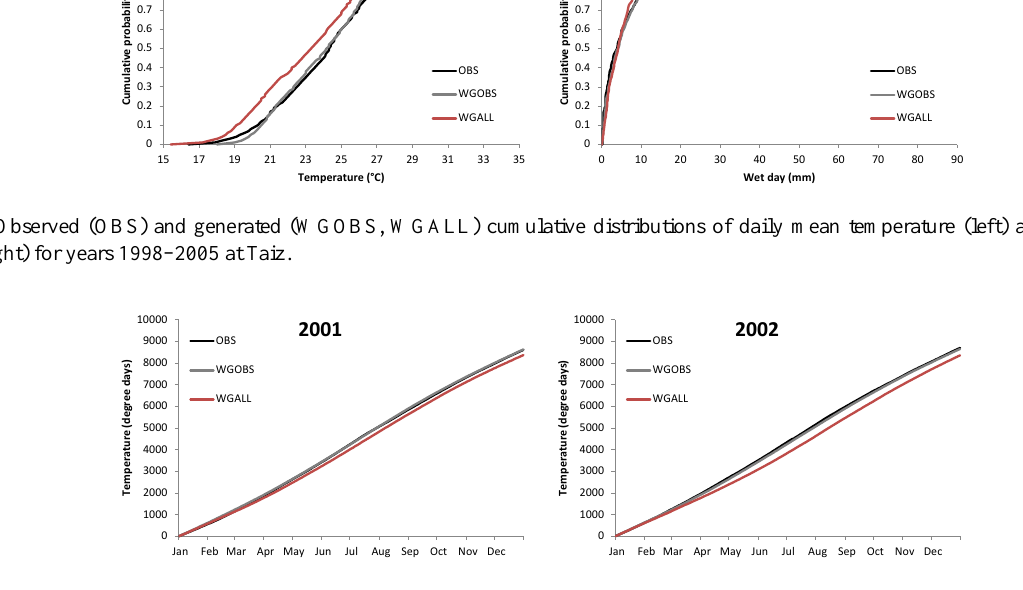
Fig. 18. Observed and generated cumulative degree day totals for calendar years 2001 and 2002 at